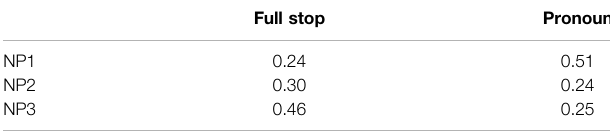
TABLE 1 | Proportion of next-mention in Experiment 1, per referent, per prompt